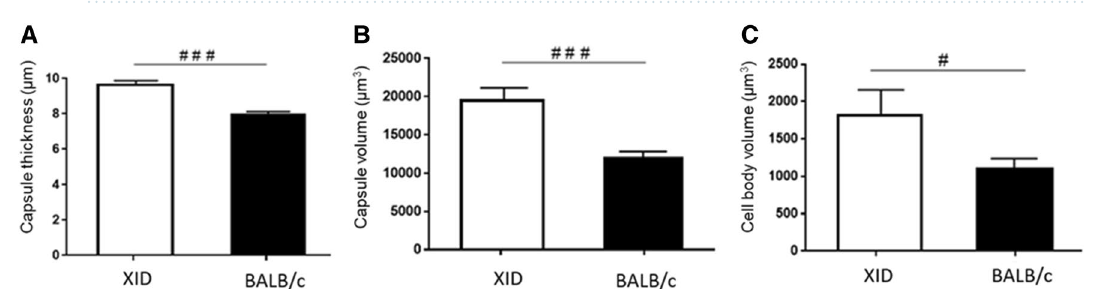
Figure 5. Analysis of C. gattii size in the BAL of XID and BALB/c mice. ( A ) Capsule thickness, ( B ) capsule volume and ( C ) C. gattii cell body volume in the bronchoalveolar lavage (BAL) of animals XID and BALB/c with 19 days of infection. Samples fixed with 4% formaldehyde, stained with India ink and analyzed under a microscope at 400 × magnification. The graphs show the results of 2 independent experiments (n = 5). ( ### p < 0.001; # p <